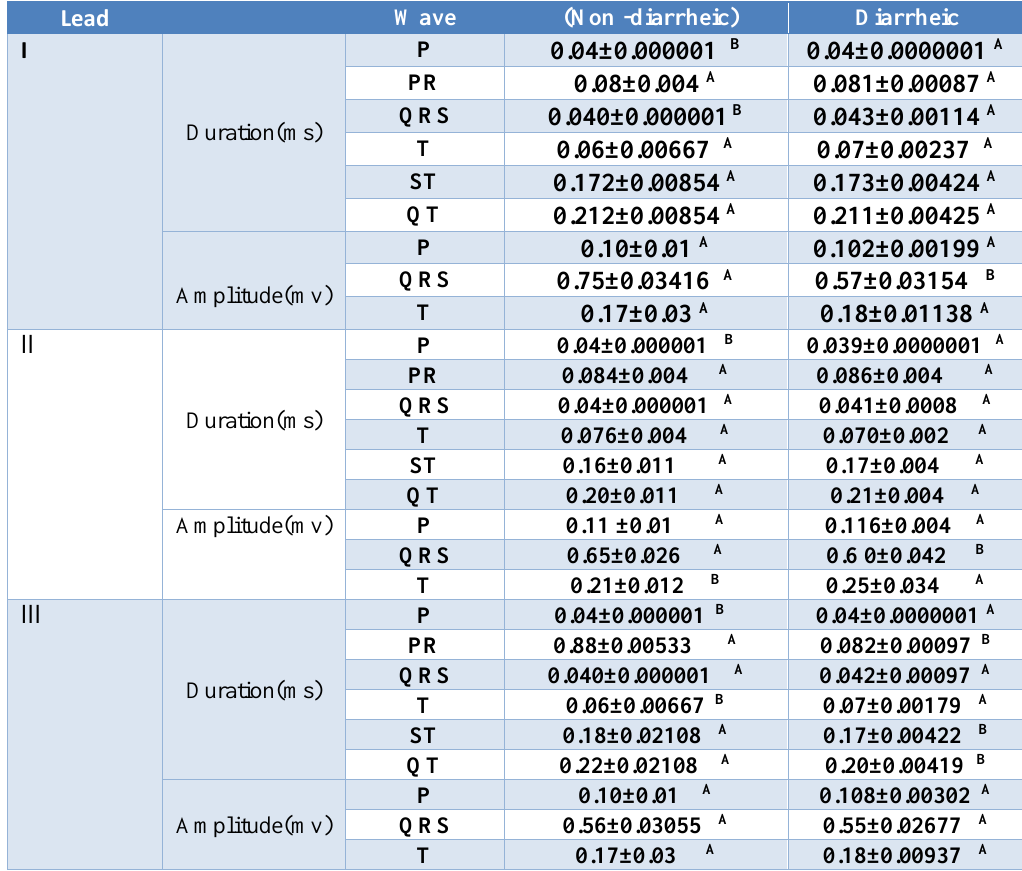
Table (1) Electrocardiograph values in different bipolar lead (mean± ST) in non-diarrheic and diarrheic